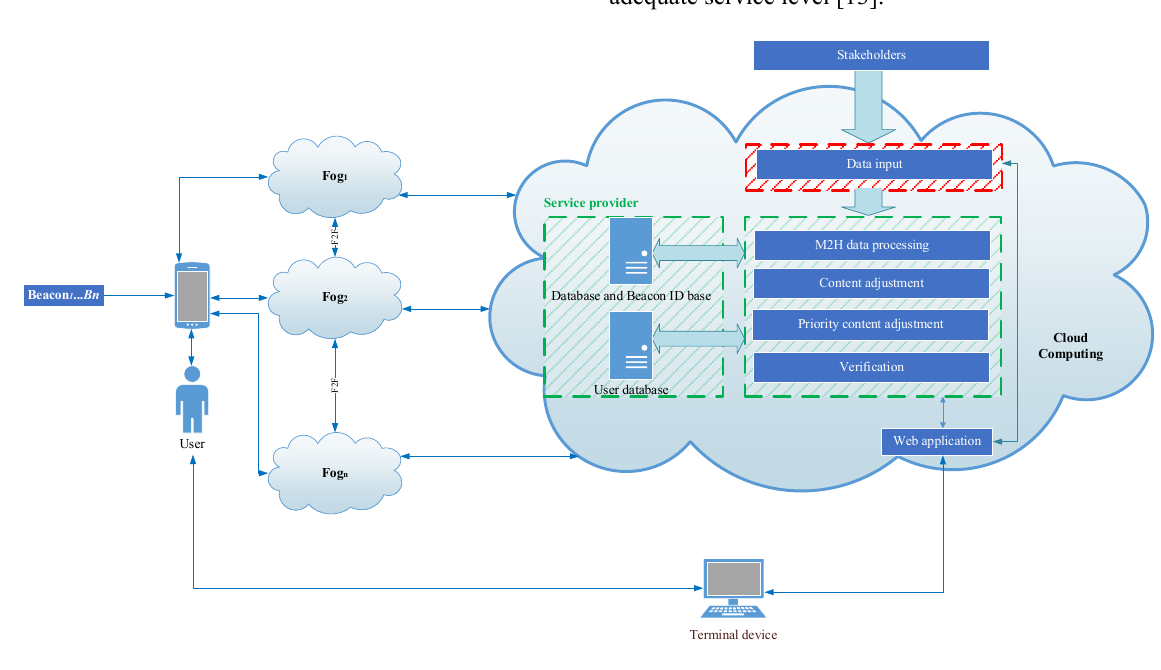
Figure 2. Conceptual system